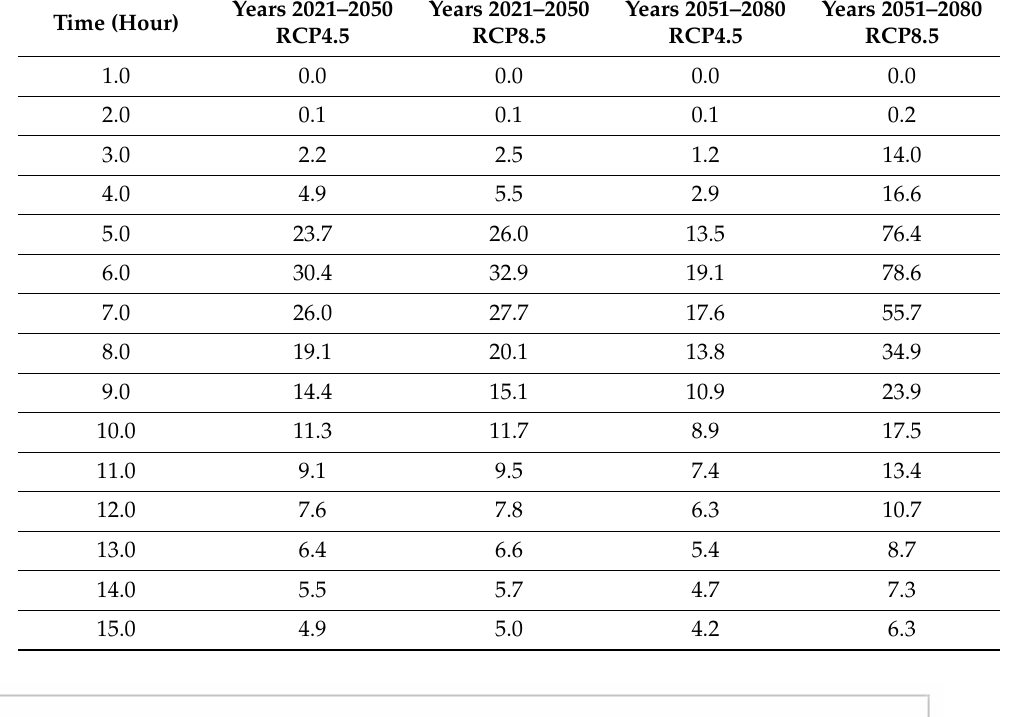
Table 12. Flood hydrographs for RCP4.5 and RCP8.5 scenarios from 2021 to 2050 and from 2051 to 2080.